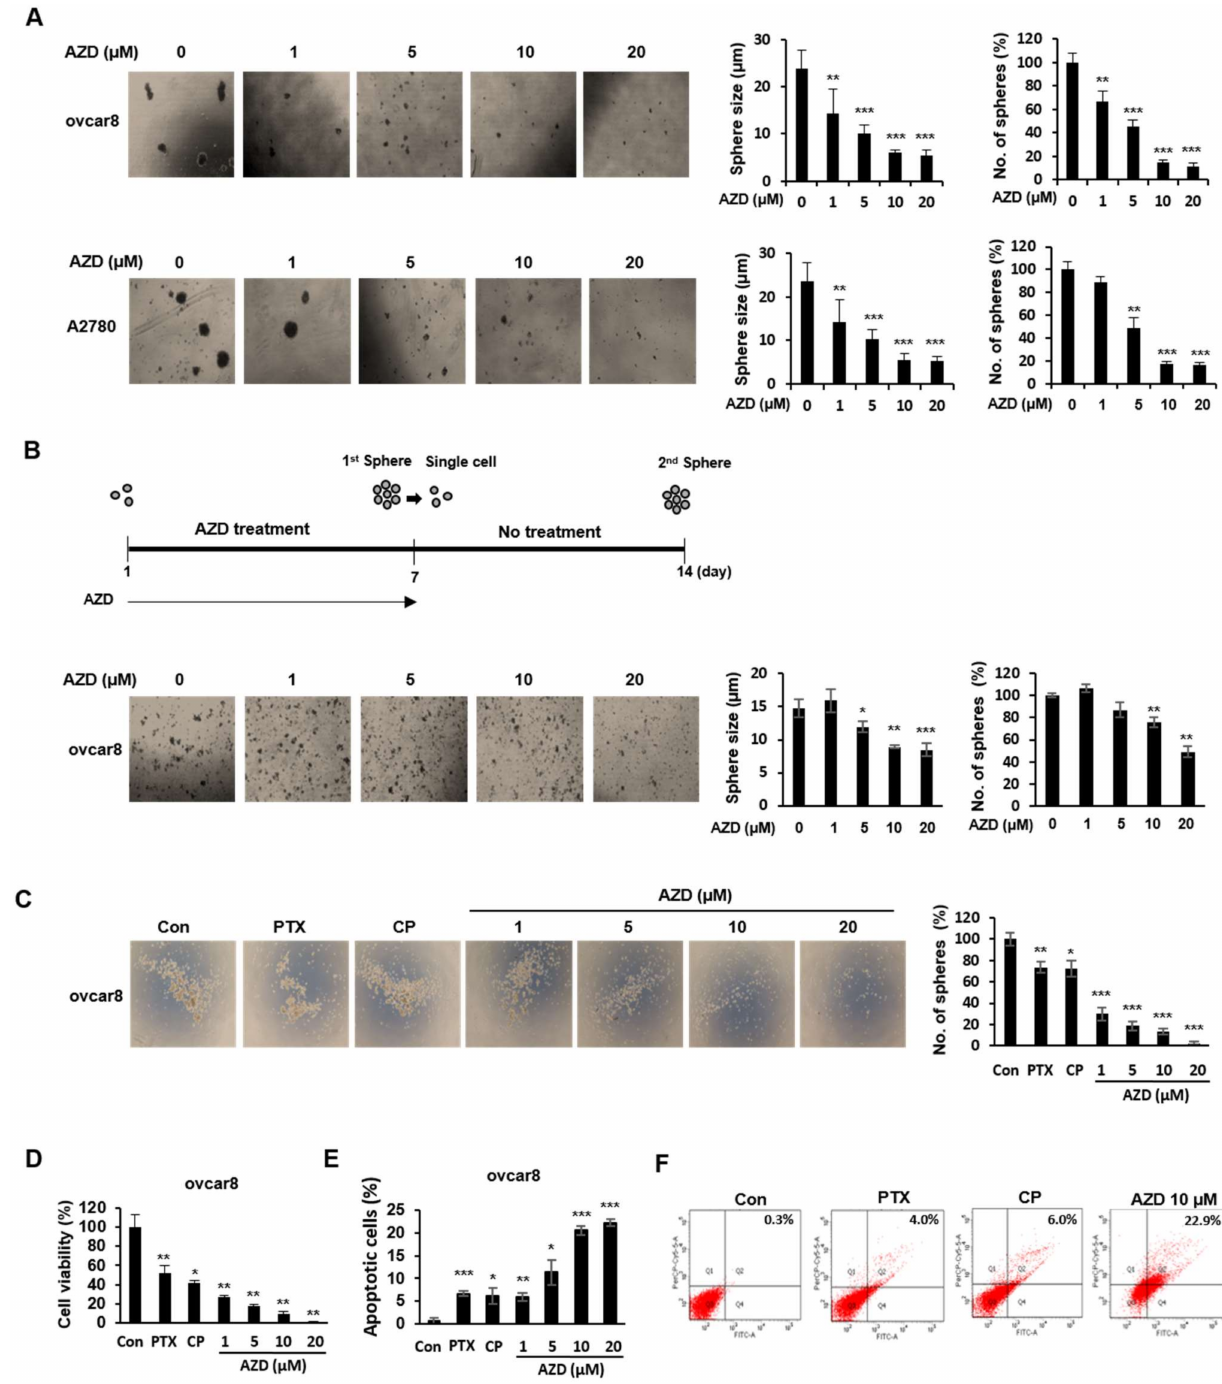
Figure 5. AZD4547 impedes the cancer stemness characteristics of ovarian cancer cells. ( A ) Cells were seeded into ultra- low-attachment 6-well plates and treated with AZD4547 for 7 days. Left panel, representative images of sphere-forming cells. Right panel, quantification of the size and number of sphere-forming cells. ( B ) Spheroid cells were collected and dissociated into single cells. Single cells were again seeded into ultra-low-attachment 6-well plates and cultured without AZD treatment for 7 days. Left panel, representative images of sphere-forming cells. Right panel, quantification of the size and number of sphere-forming cells. ( C ) Ovcar8 cells were seeded into ultra-low-attachment 6-well plates and treated with paclitaxel (PTX, 5 nM), cisplatin (CP, 10 µ M), and AZD4547 (0, 1, 5, and 10 µ M) for 7 days. Left panel, representative images of sphere-forming cells. Right panel, quantification of the size and number of sphere-forming cells. ( D ) Ovcar8 cells were treated with AZD4547 for 7 days, then cell viability was determined using the CCK-8 assay. ( E , F ) Apoptosis of ovcar8 cells were determined by FACS analysis. PTX, paclitaxel; CP, cisplatin; AZD, AZD4547. * p < 0.05, ** p < 0.01, *** p <